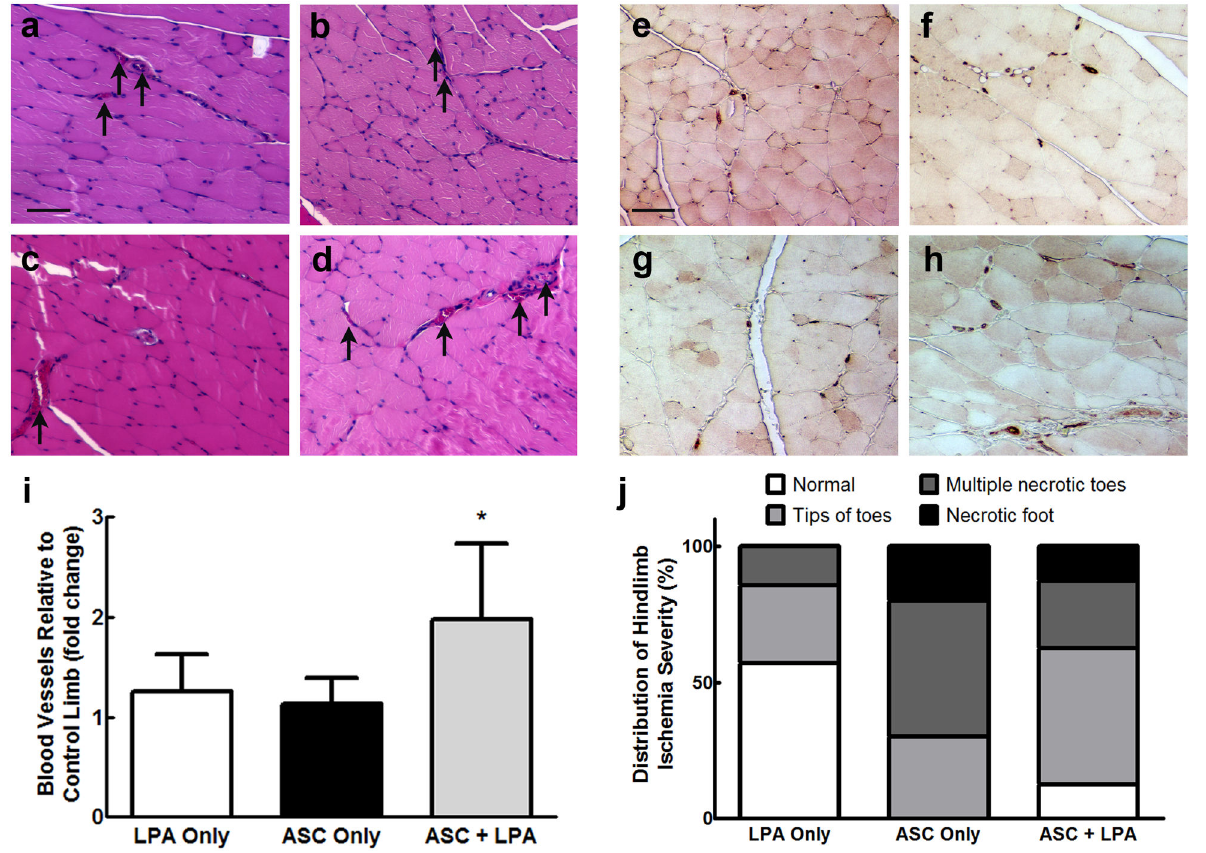
Figure 4. Co-delivery of LPA with ASC in fibrin gels significantly improves angiogenesis in a murine model of critical limb ischemia. Representative H&E stained sections from the quadriceps of ( a ) normal hindlimbs and ( b ) ischemic limbs treated with fibrin gels containing 25 μM LPA, ( c ) ASC, or ( d ) LPA and ASC show the presence of more large vessels in limbs treated with cells and LPA together. Similarly, CD31 staining reveals the formation of larger intramuscular blood vessels in limbs receiving ( h ) both LPA and ASC, while ( e ) normal tissue and defects receiving ( f ) LPA and ( g ) ASC alone have fewer and smaller vessels. ( i ) Blood vessel quantification from H&E stained sections confirms these results ( n=8 ). Scale bars represent 100 μm; arrows indicative of vessels with defined lumens and erythrocytes. * p < 0.05 vs. other groups. ( j ) Hindlimbs were visually assessed for severity of toe and foot necrosis in each treatment